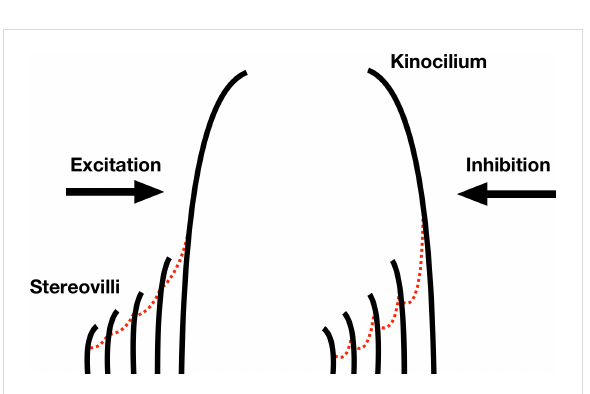
Figure 2: Simplified 2D model of a neuromast hair cell bundle of fish: stereovilli increase in stepped length up to the tallest kinocilium. Stere- ovilli and kinocilium are connected by tip links (red dotted line). Me- chanical work (bending) stretches the tip links and pulls ion channels open. The channel opening causes a change of cell potential which in turn triggers an action potential. Mechanical deflection of the kinocilium away from the stereovilli causes excitatory response and vice versa (toward stereovilli) causes inhibitory